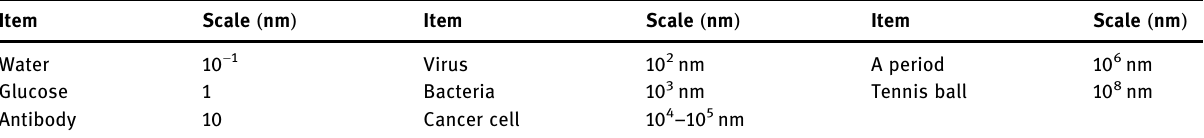
Table 1: Scale range in nanometer